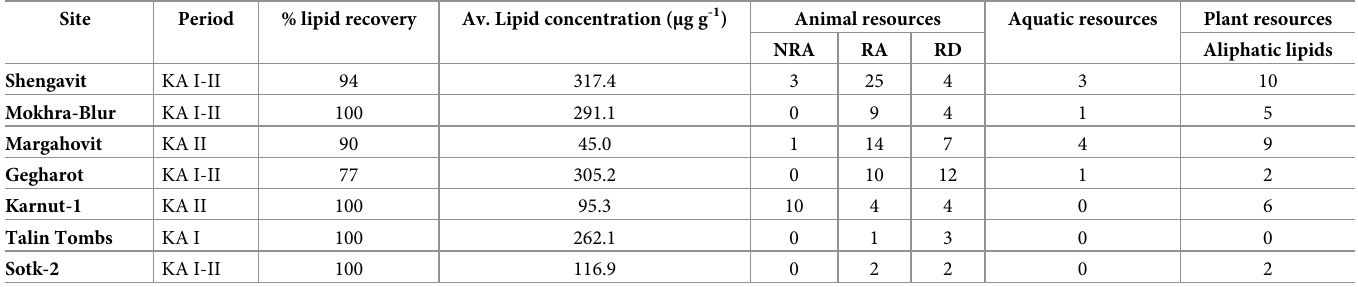
Table 1. Summary of occurrence of lipid classes detected in pottery vessels at each site.